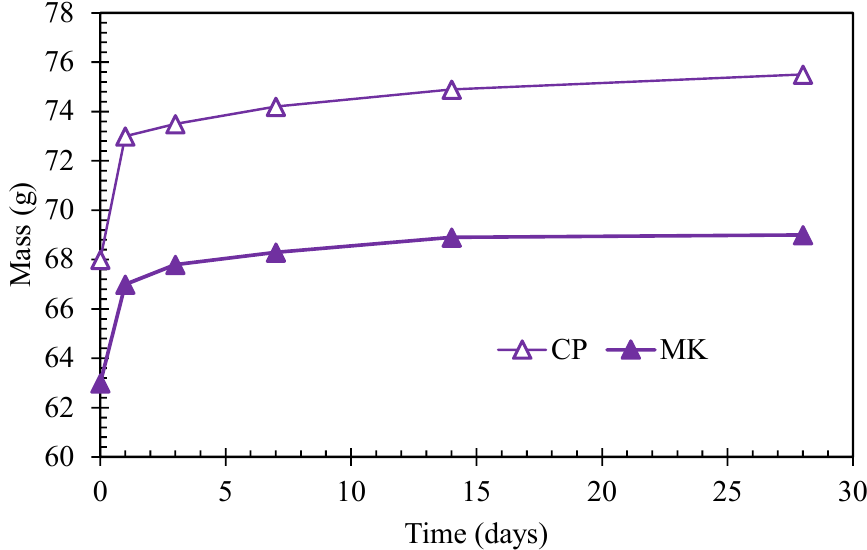
Figure 11. Mass change of cement paste and metakaolin-cement paste under the water absorption test before elevated temperature exposure.